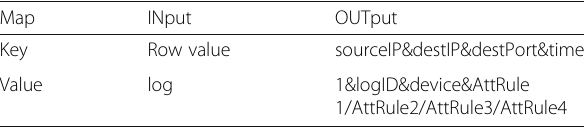
Table 5 The Map phase input and output of the attack class